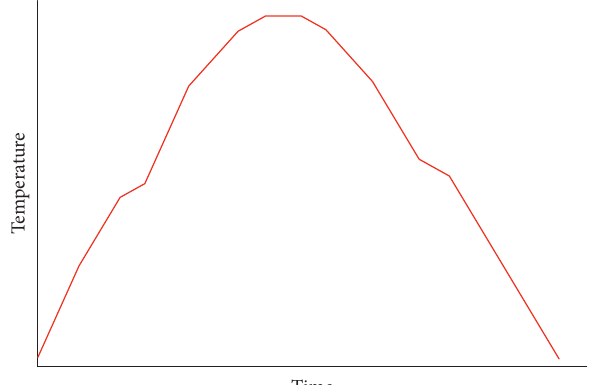
Figure 1: Typical heating and cooling of ceramic products during firing